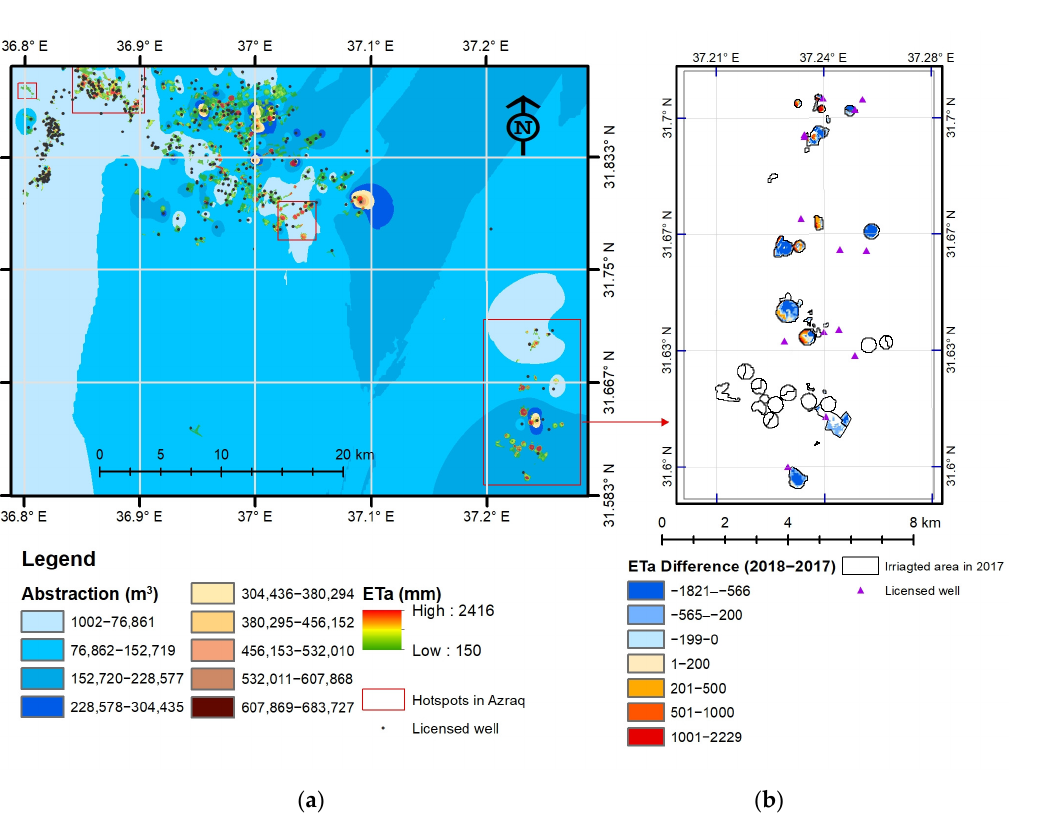
Figure 13. Application of spatial analysis to identify hotspots with illegal access to water resources: an example from Azraq irrigated zone. ( a ) Overlay of groundwater abstraction map with the map of ET-density of 2017 to identify and delineate hotspots; ( b ) Analysis of changes in irrigated area and water consumption in the area of Hazeem after implementation of a campaign by MWI in 2018 to shutdown illegal wells.